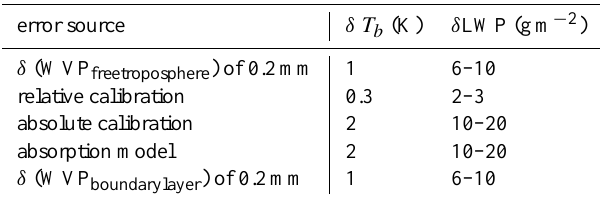
Table 2. Major error sources within the GVR LWP